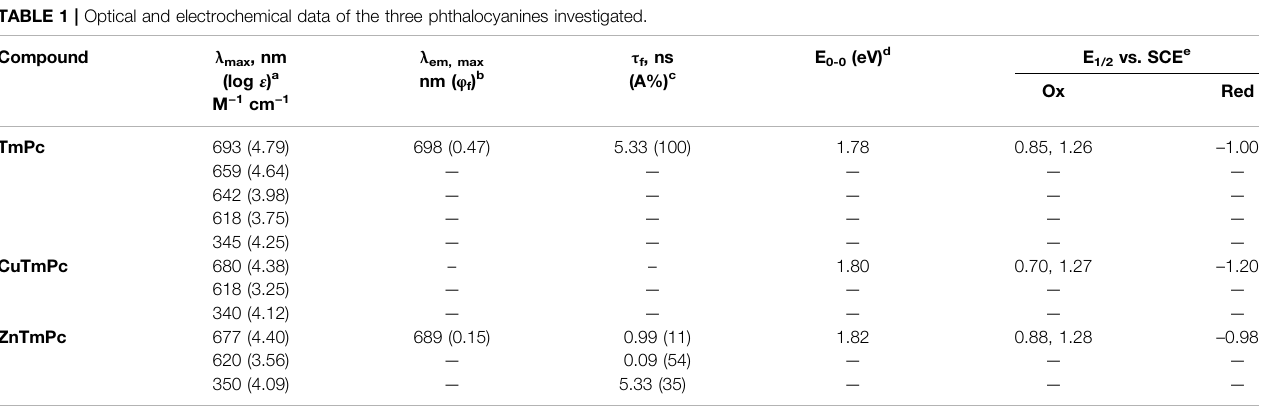
TABLE 1 | Optical and electrochemical data of the three phthalocyanines investigated.